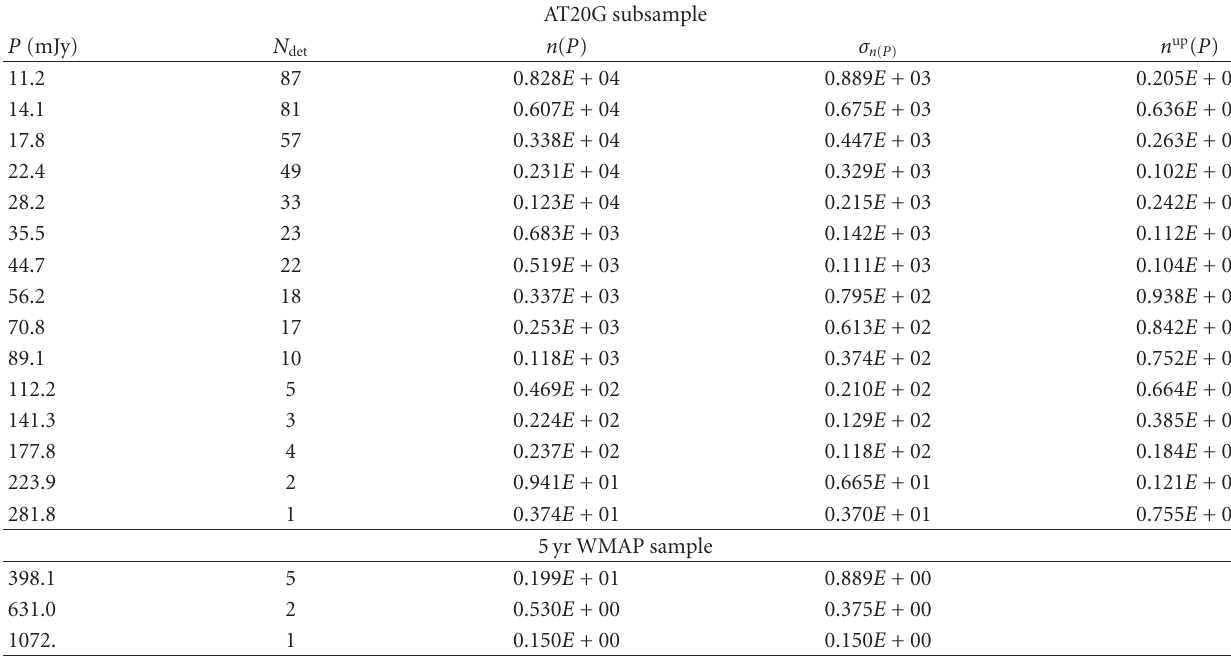
Table 3: Number counts in polarization at 20 GHz from WMAP and AT20G source catalogues. N det indicates the number of objects with detected polarization, while n up ( P ) is the estimated contribution of AT20G objects with no polarization information or with upper limits in the fractional